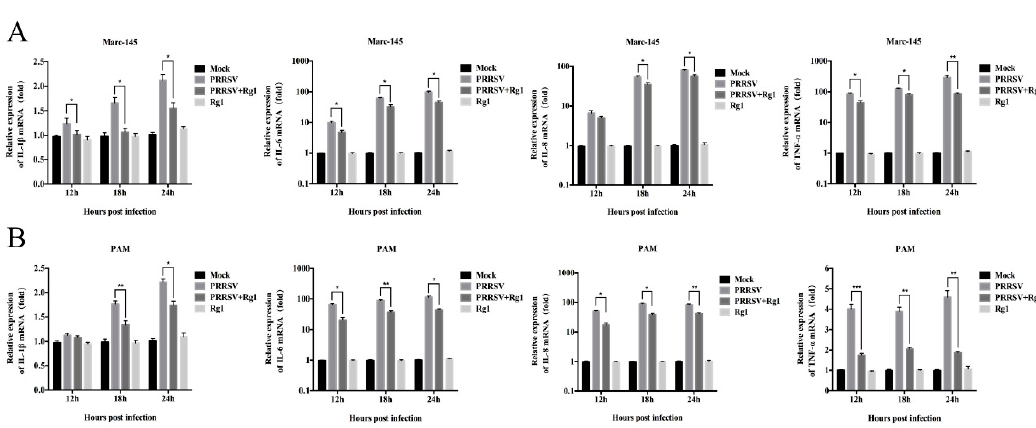
represent three independent IFA trials with similar results. Magnification, 100 × . ( B , C ) The inhibitory e ff ect of Rg1 on PRRSV replication in Marc-145 cells ( B ), and PAMs ( C ). PRRSV replication was analyzed by virus growth curve. Marc-145 cells and PAMs were seeded in 6-well plates and infected with four PRRSV strain (0.1 MOI) for 1 h at 37 ◦ C respectively and then cultured with DMEM or RPMI 1640 supplemented with 10 or 50 µ M Rg1 or DMSO. Cell supernatants (200 µ L) of each well were collected at indicated hours of post-infection. Growth assays for each group were performed in triplicate, and the resulting titers were determined as TCID 50 / mL (the 50% tissue culture infectious dose per mL) and the data are shown as the means ± SD. T-test was applied to perform statistical analysis. Statistical significance between 10 µ M Rg1 and DMSO is denoted by * p < 0.05 and ** p < 0.01, and significance between 50 µ M Rg1 and DMSO is denoted by # p < 0.05 and ## p < 0.01.